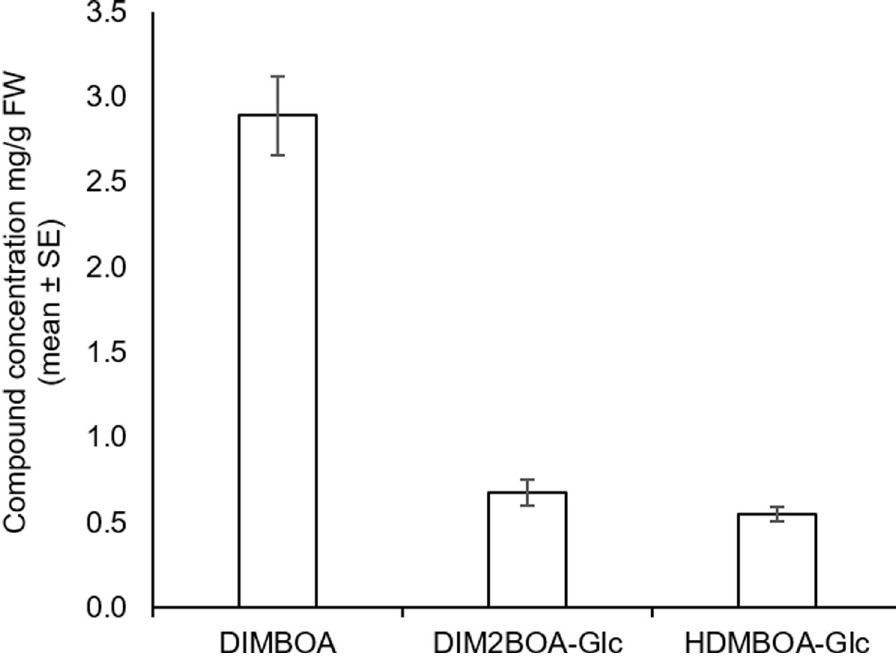
Fig 4. Benzoxazinoid contents in Svevo leaves. DIMBOA, DIM2BOA-Glc and HDMBOA-Glc abundance detected by HUPLC (mean ± SE; n = 5–7).